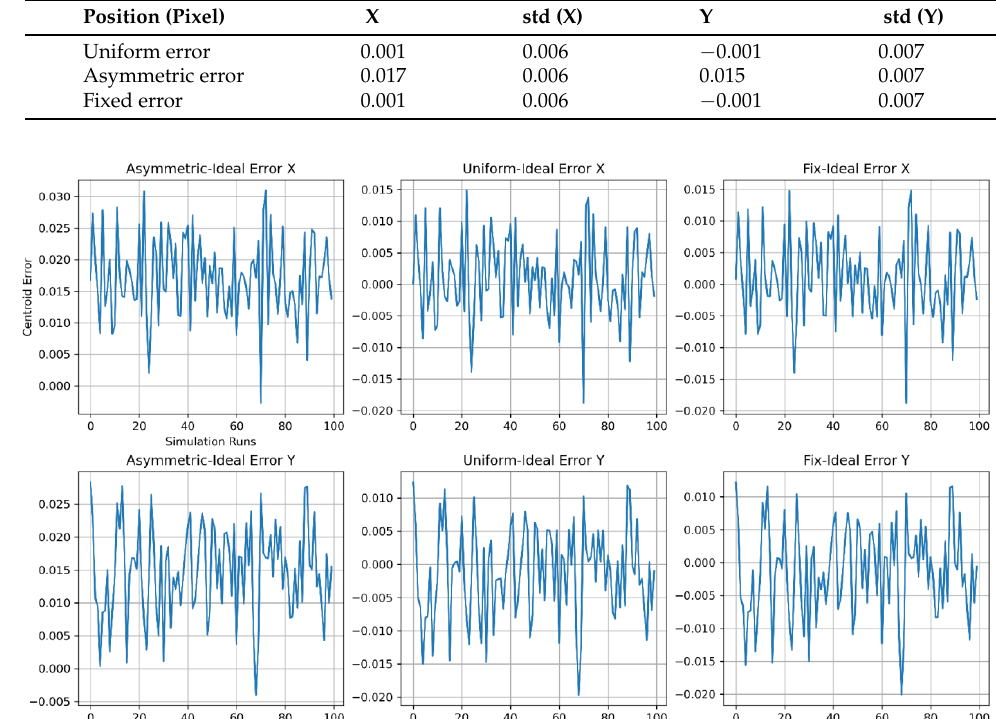
Figure 7. Statistical results on position accuracy by random source positions with randomly dis- tributed